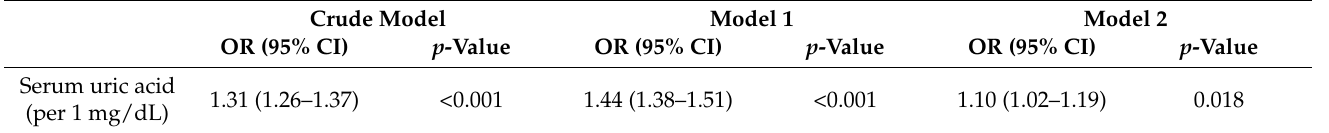
Table 3. The association between serum uric acid level and having a high CVD risk.